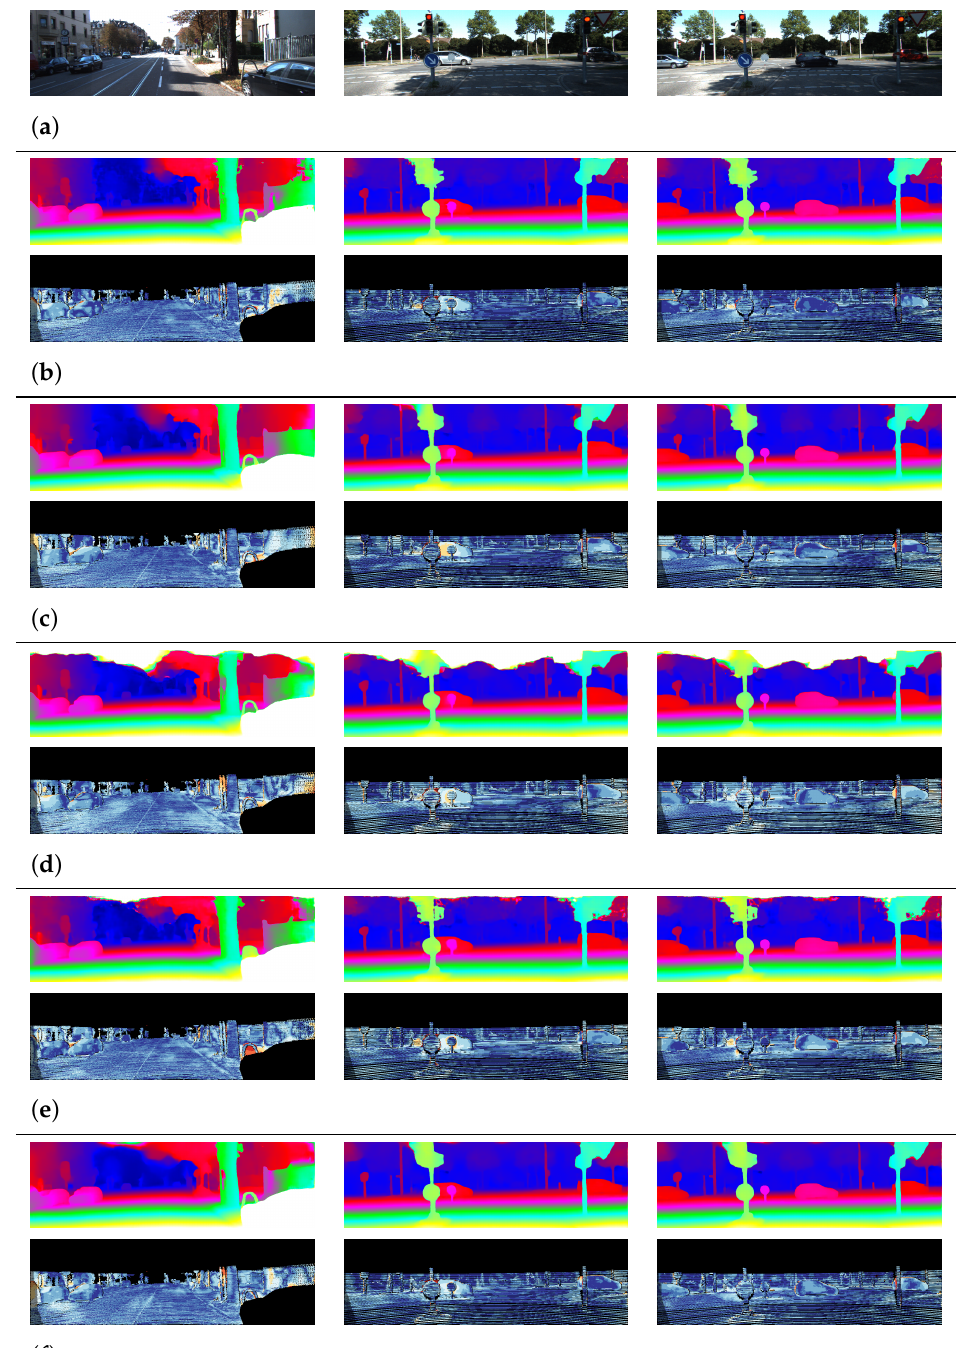
Figure 10. Qualitative comparison on the KITTI-2015 test set. ( a ) Input Image. ( b ) PSMNet [12]. ( c ) DeepPruner-Fast [26]. ( d ) SFFNet [17]. ( e ) 2D-MobileStereoNet [28]. ( f )